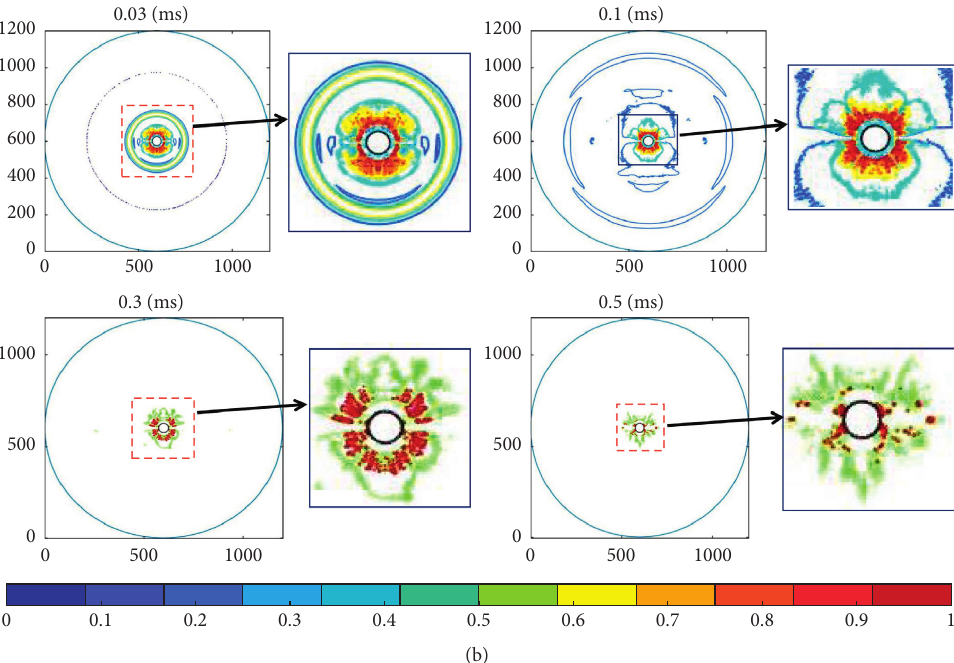
Figure 7: Damage evaluation and effective stress evaluation for 24 ° shaped energy angle blasting. (a) The development process of 24 ° energy gathering angle blasting damage. (b) Development process of equivalent stress of 24 ° shaped energy angle